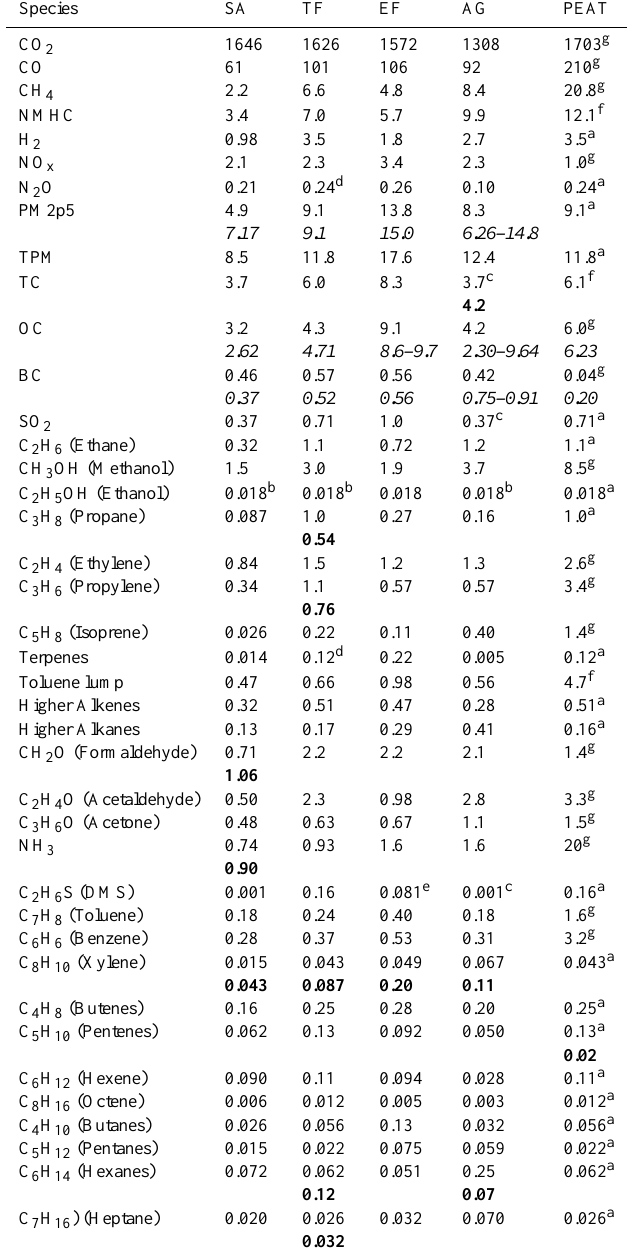
a Values from TF. b Values from EF. c Values from SA. d Values from mean of SA and EF. e Values from mean of SA and TF. f Values from sum of other species. g Values from Christian et al.